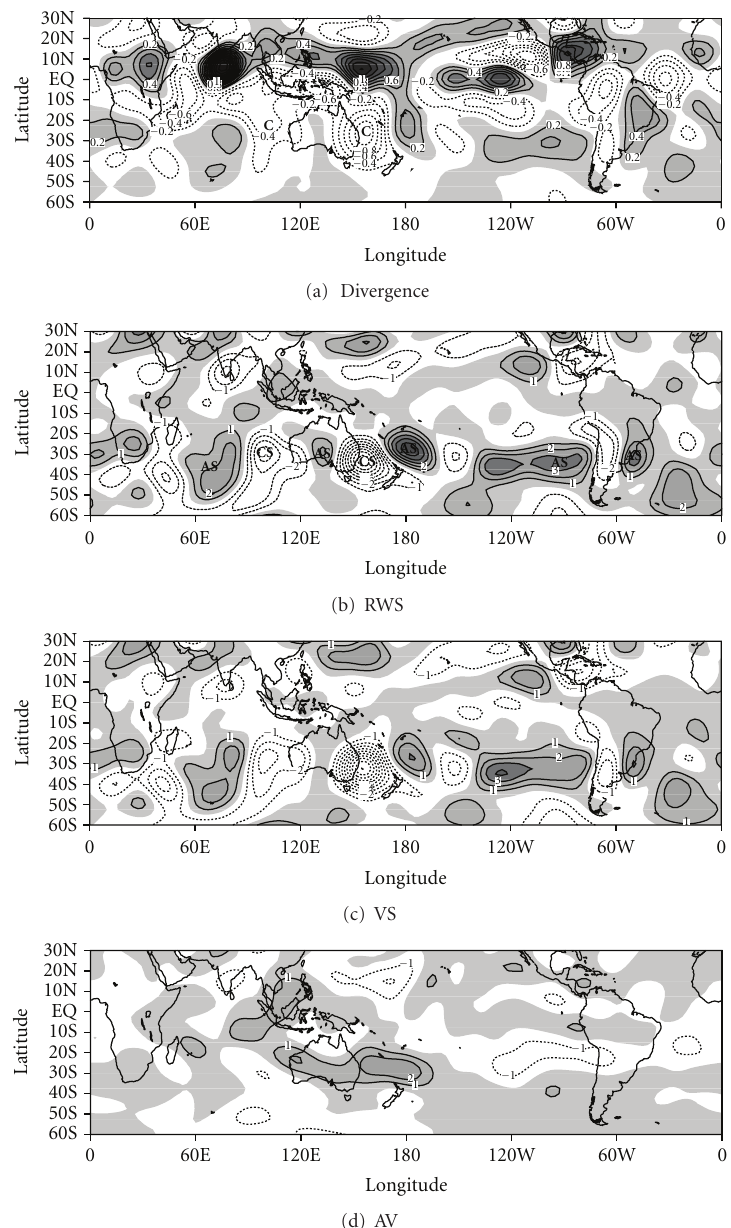
Figure 4: Anomaly for strong HC cases at 200 hPa in JJA for: (a) divergence, (b) Rossby wave source (RWS), (c) vortex stretching term (VS), (d) advection of absolute vorticity by divergent flow term (AV). The shaded areas represent positive values. The divergence contour plot has a contour interval of 0.2 × 10 − 6 s − 1 . RWS and its terms contour plots have contour interval of 1 × 10 − 11 s − 2 . The symbols C and CS are described in the